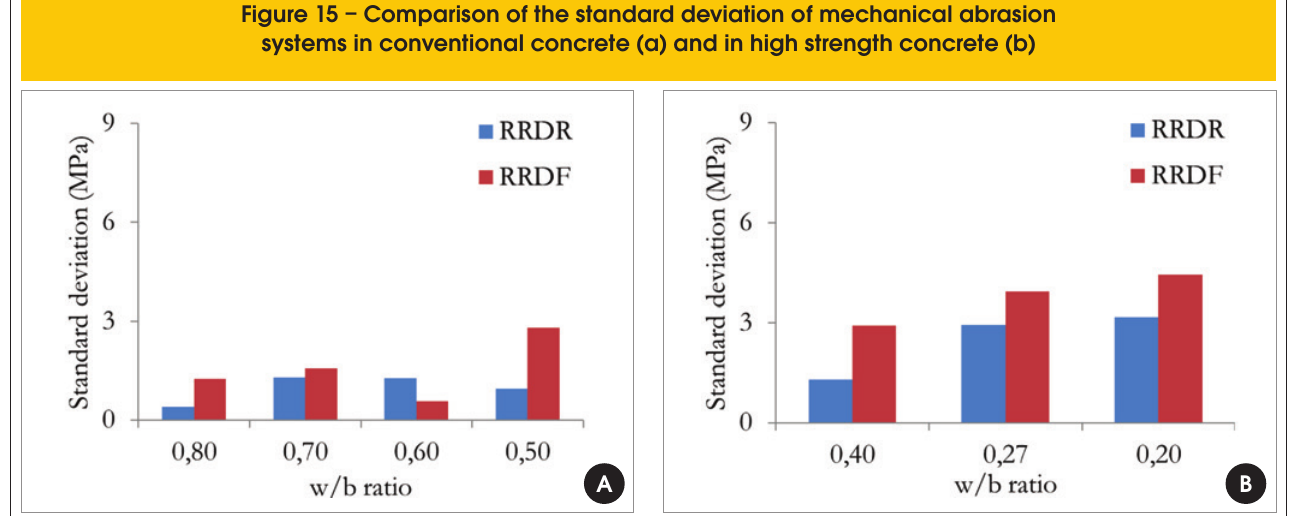
Figure 15 – Comparison of the standard deviation of mechanical abrasion systems in conventional concrete (a) and in high strength concrete